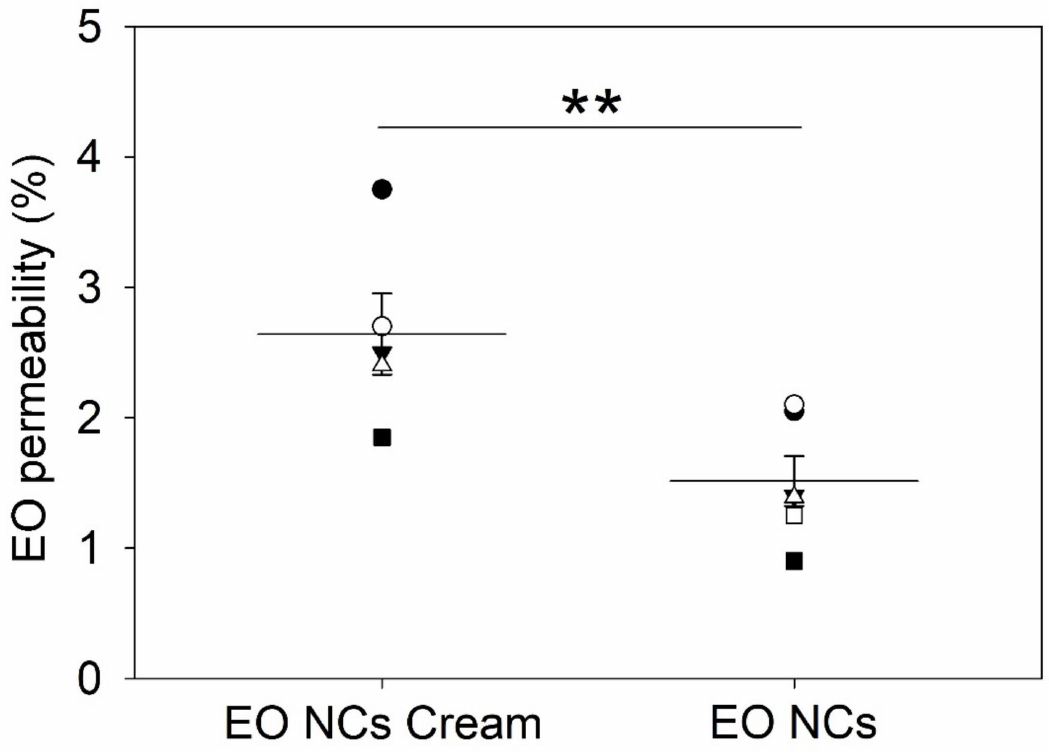
Figure 5. Percentage of EO permeation through the skin after 2 h of administering the EO-loaded NCs and the EO-loaded NC creams. Data are expressed as the mean of five replicates ± standard deviation. ** stands for p < 0.05, considered statistically